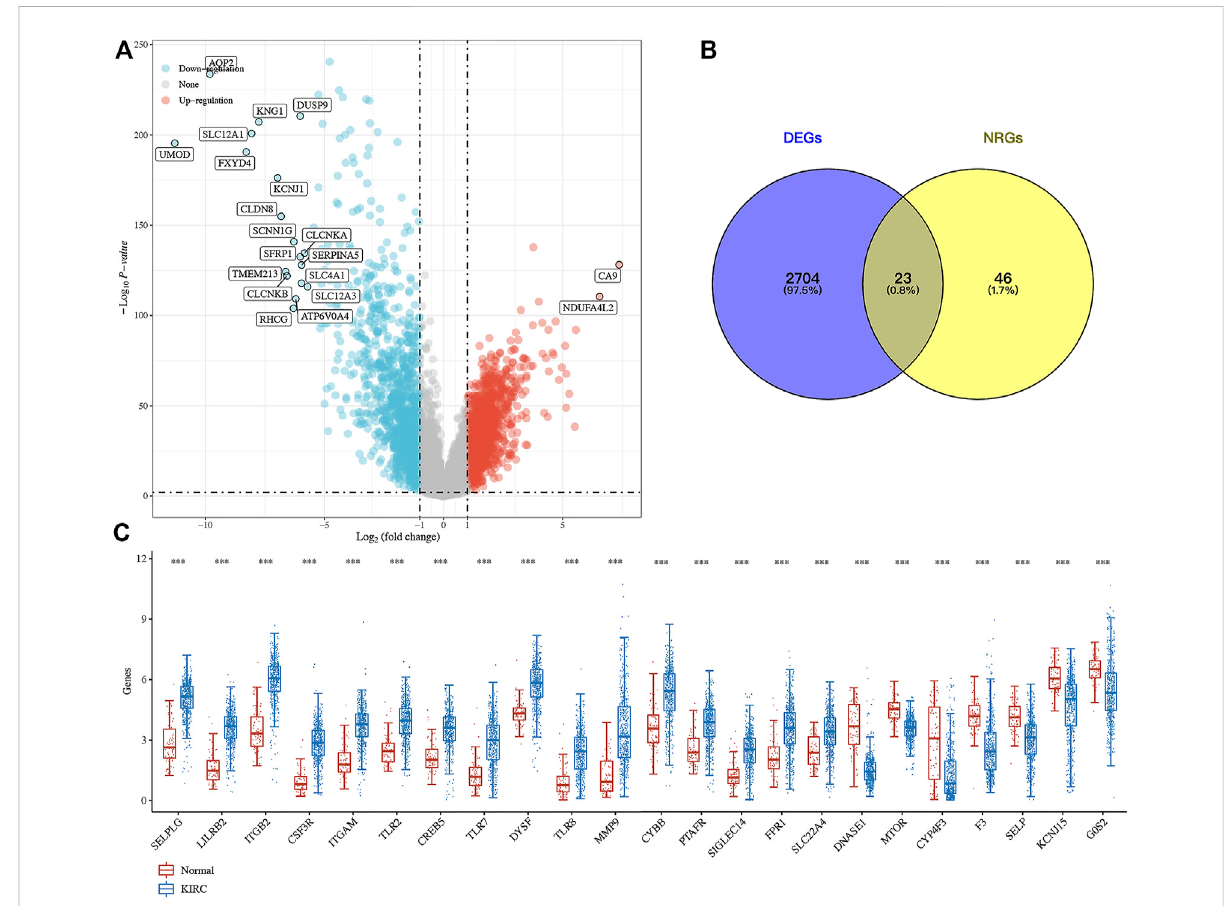
FIGURE 1 Expression landscape of neutrophil extracellular trap-related genes in ccRCC. (A) Volcano plot about the differentially expressed genes in ccRCC. (B – C) Venndiagramaboutthenumberofdifferentiallyexpressedneutrophilextracellulartrap-relatedgenesinccRCC.*** p < 0.001;ccRCC, clear cell renal cell